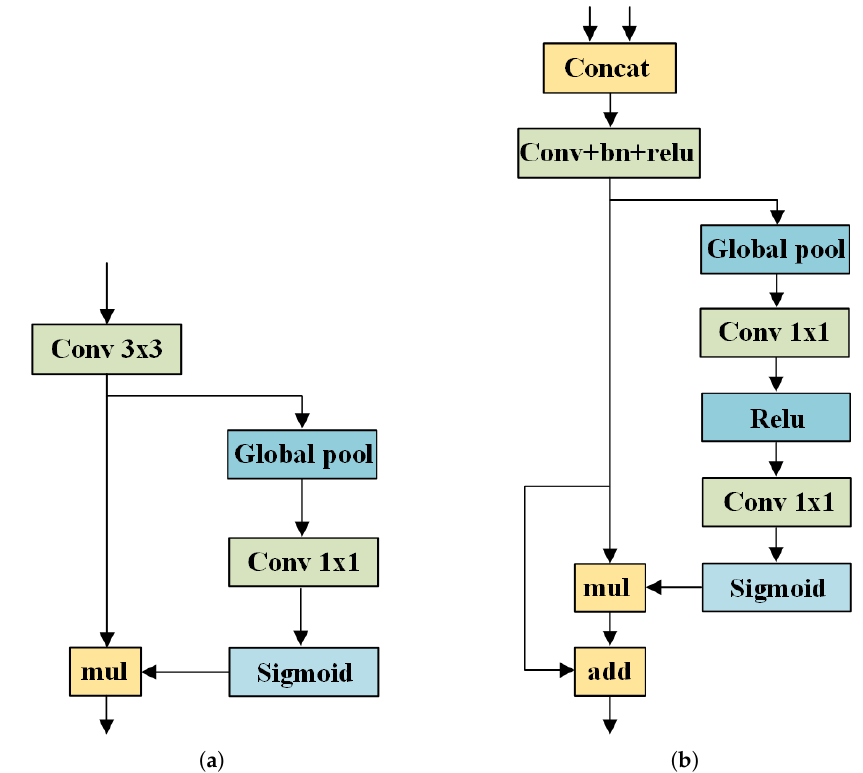
Figure 2. ( a ) Structure of GCM; ( b ) structure of